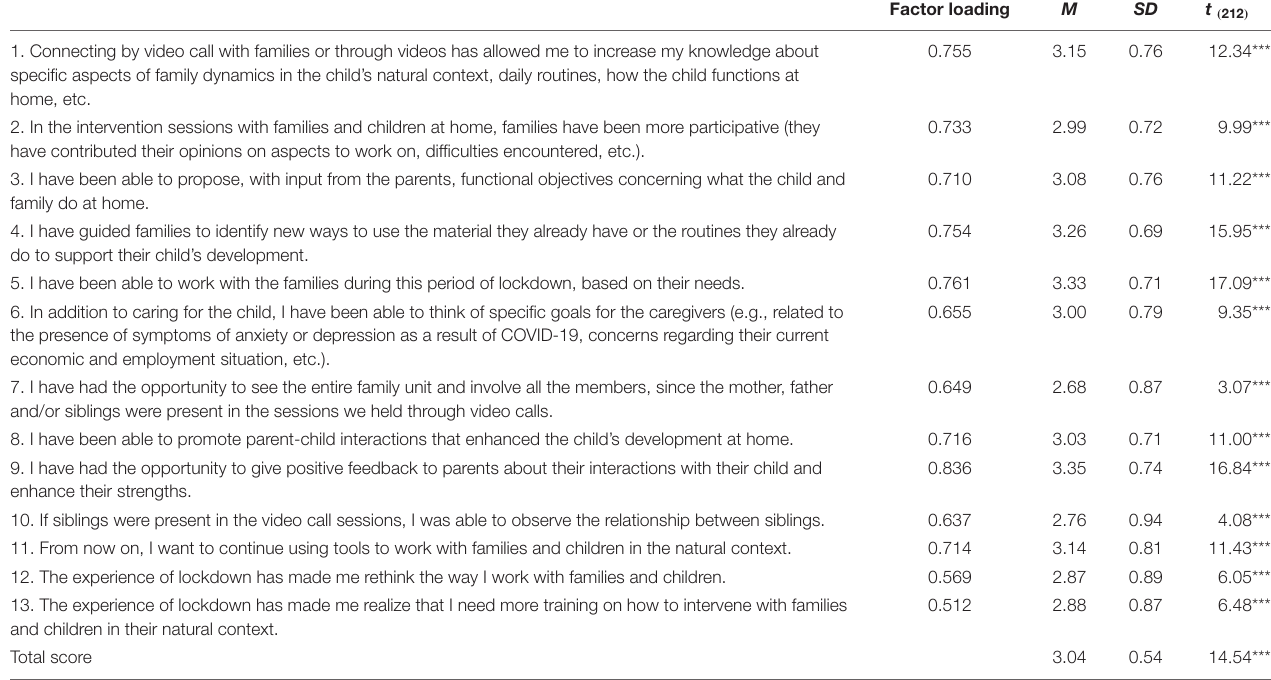
TABLE 4 | Exploratory factor analysis and descriptive statistics for the questionnaire answered by the professionals ( n =